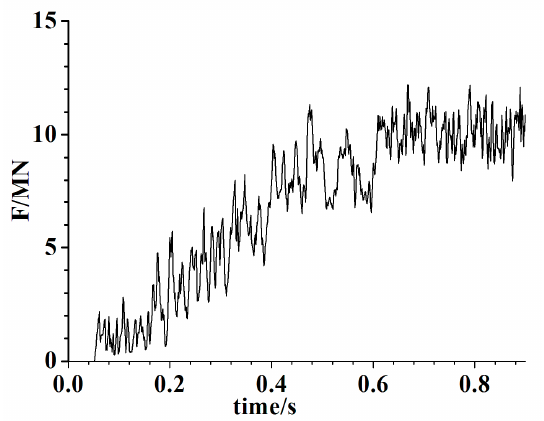
Figure 7. Force-time curve of the collision model between ice sphere and rigid plate.